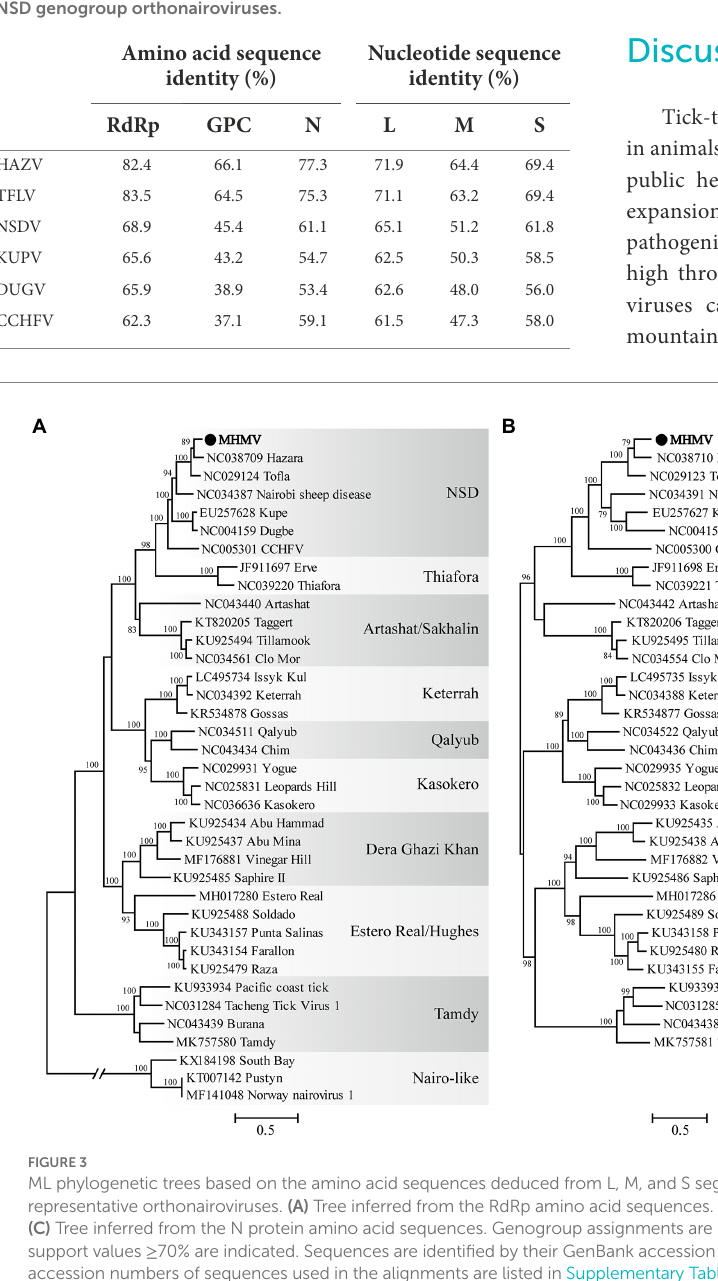
TABLE 1 Amino acid sequence and nucleotide identity of MHMV RdRp (L segment), GPC (M segment), and N protein (S segment) with the NSD genogroup orthonairoviruses.